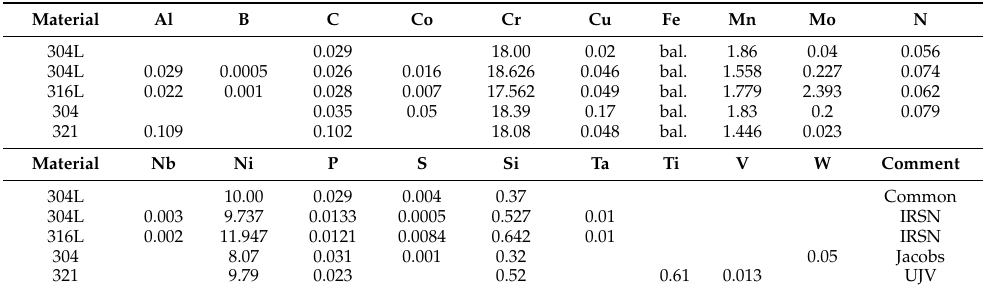
Table 1. Chemical composition of the different steels (wt.%). The common material (see column “Comment”) was used in the majority of the tests; the other materials were only used by the indicated